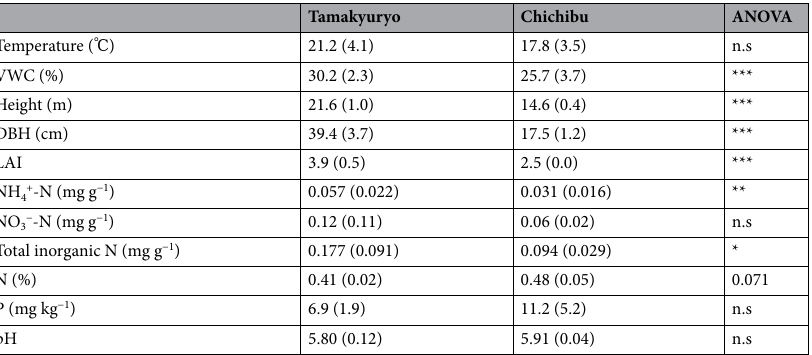
Table 1. Mean air temperature and volume water content from April to September 2018, the height, diameter of the breast height (DBH) and the leaf area index (LAI) of Q. serrata grown in FM Tamakyuryo and FM Chichibu in 2018, the concentrations of inorganic nitrogen (NH 4+ -N, NO 3− -N and total of them) and available phosphorus, and pH in the soils of FM Tamakyuryo and FM Chichibu 2018. Temperature and VWC is mean of 1 h average value from April to September 2018. Height, DBH, LAI, NH 4+ -N, NO 3− -N, total nitrogen, available phosphorus and pH are mean value of nine individuals or soils. Each value is mean value and values in parentheses indicate standard deviation. One-way ANOVA: * p < 0.05, *** p < 0.001, n.s. not significant. Actual p value is shown if 0.05 ≤ p < 0.10.